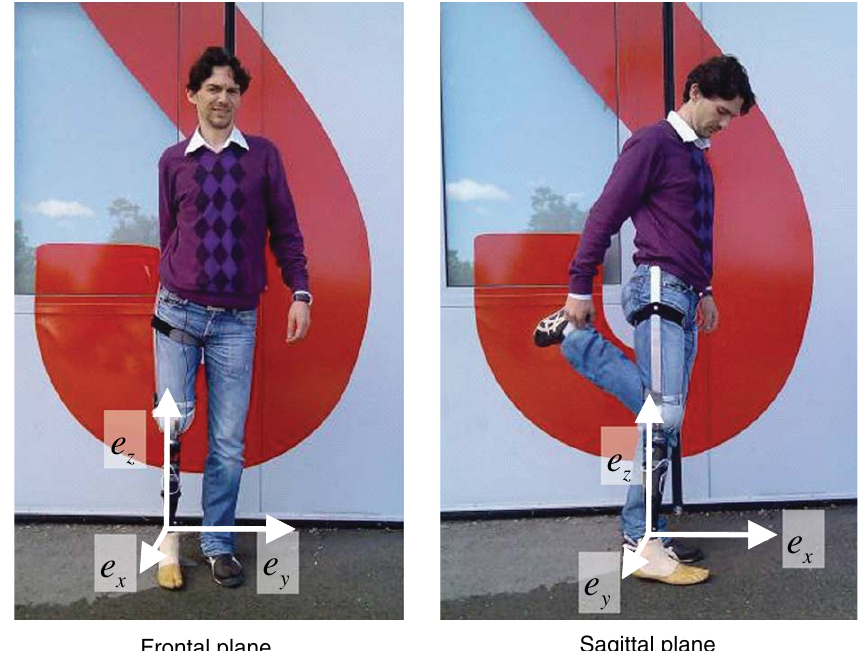
Fig. 6. Able-bodied subject wearing the